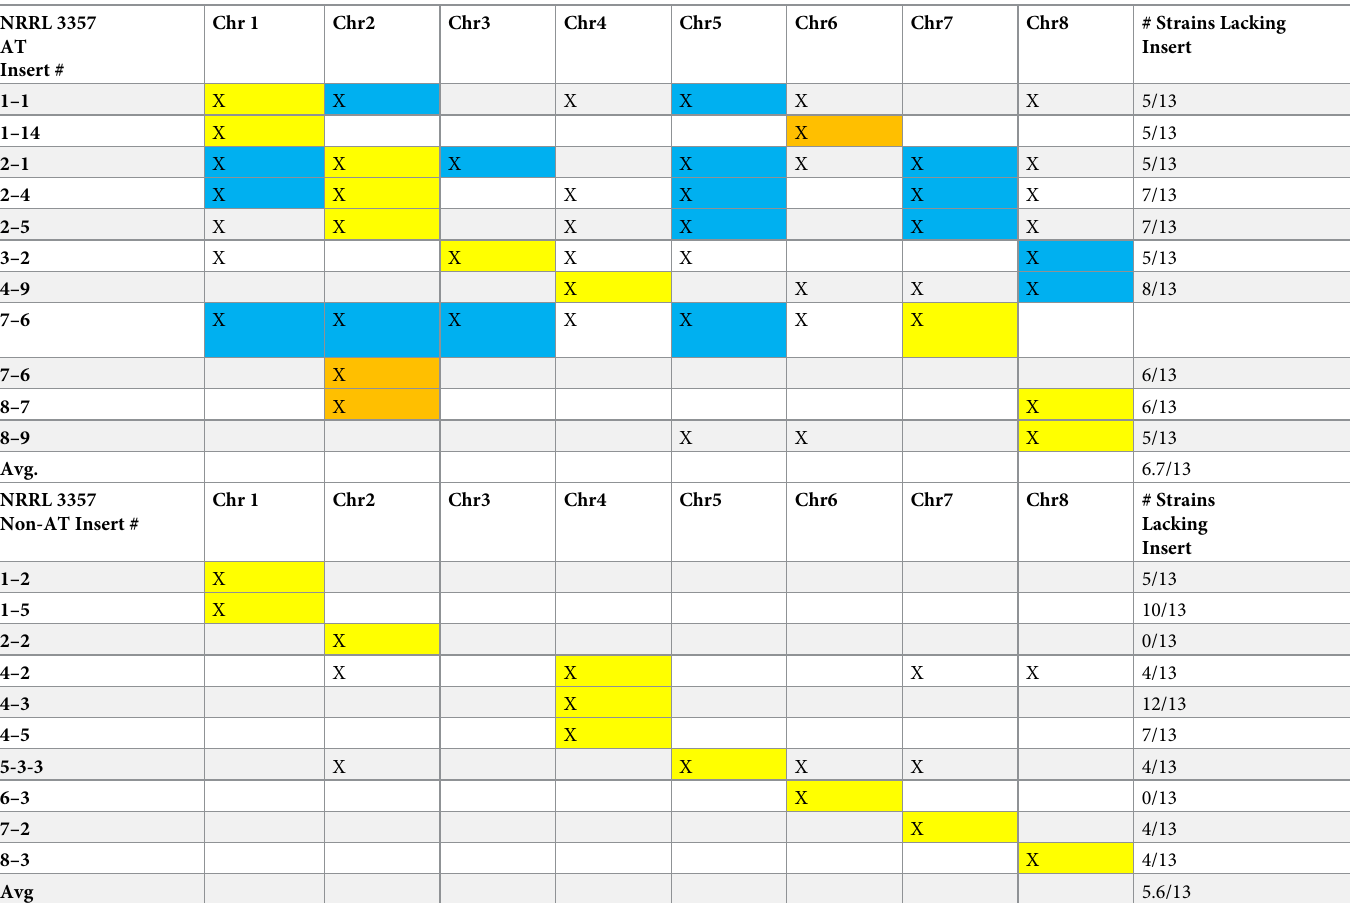
(top) Comparisons of homology between each NRRL 3357 AT Inserts (AT Insert #) and the chromosomal location (Chr1 to Chr8) of each homolog in the 12 strains (other than the CA14 strain used for initial analysis) at allelic sites within the same chromosome in genomes including (at a minimum) NRRL 3357 (Yellow Shaded X), at non-allelic sites in genomes including (at a minimum) NRRL 3357 (Blue Shaded X), or at non-allelic sites exclusively in strains other than NRRL 3357 (non-shaded X). In additional, non-allelic homologs in CA14 is shown as a brown shaded X). The right column represents the number of strains that lost the AT insertion at allelic or non-allelic positions in 13 strains analyzed (excluding the strain-either NRRL 3357 or CA14-that was used for the initial identification of indels). The average strain loss is listed in the bottom row. (bottom) Comparisons of homology between each NRRL 3357 non-AT Insertion (Non-AT Insert #) and each chromosomal homolog (Chr1 to Chr8) [other than the strain used for initial analysis (CA14)) at allelic sites in genomes including (at a minimum)NRRL 3357 (Yellow Shaded X) or at non-allelic sites exclusively in genomes other than NRRL 3357 (non-shaded X). The right column represents the number of strains that lost the non-AT insertion in the 13 strains analyzed. The average strain loss is listed in the bottom